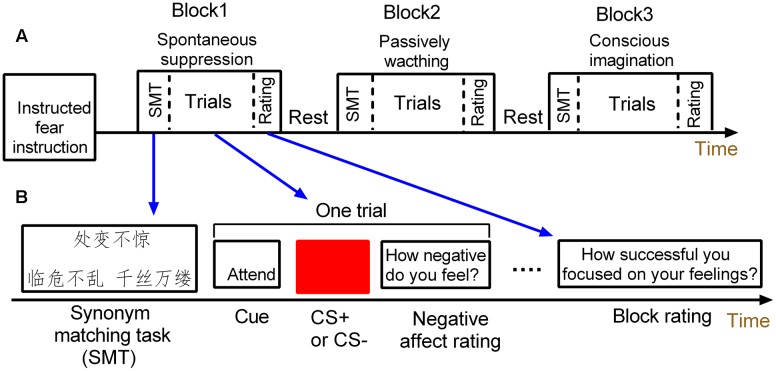
Schematic of the mixed design.
(A) The mixed design has three task blocks. (B) Each task block consists of a synonym matching task, four threat and four safety trials and one block rating.